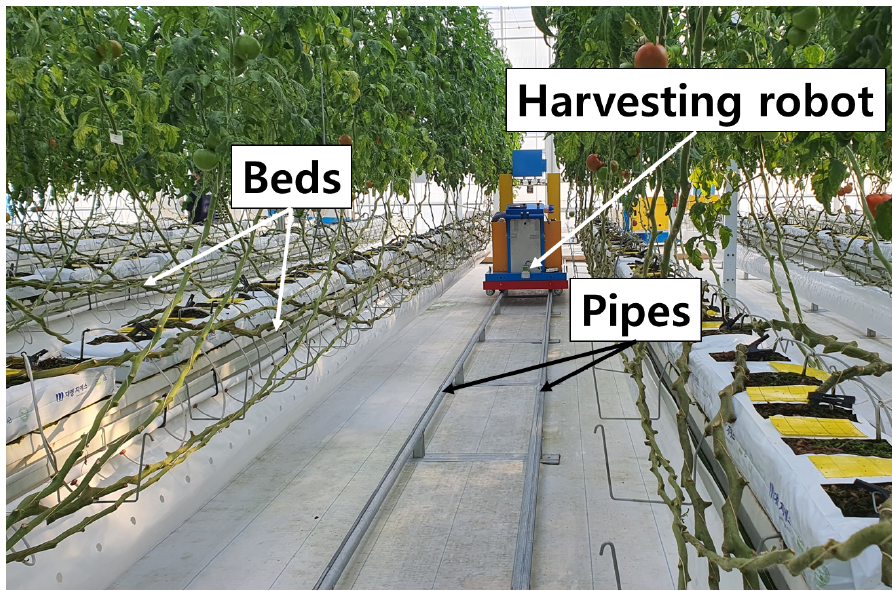
Figure 2. Beds and pipes of